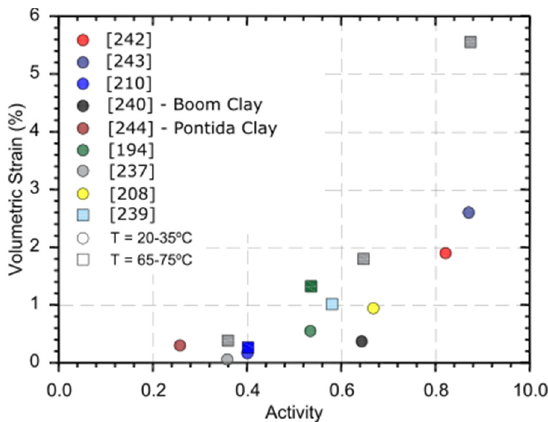
Figure 26. Evolution of volumetric strain with clay activity (adapted from Reference [26] using data from References [198,212,214,217,219,220,222–224]).